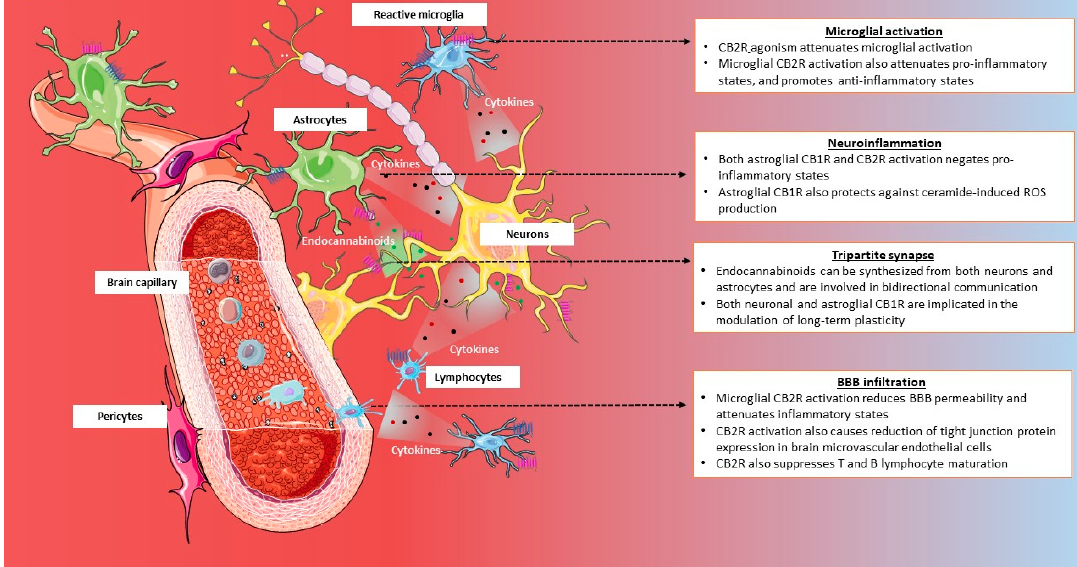
Figure 4. Regulation of synaptic activity and neuroinflammatory states by cannabinoid receptors. CB2R located on both microglial and astroglial cells are involved in the attenuation of inflammatory states. They do so by inhibition of microglial activation, reduced secretion of pro-inflammatory cytokines, and increased secretion of anti-inflammatory cytokines, and limiting the infiltration of peripheral immune cells. The CB2R is also expressed in the brain microvascular endothelial cells whereby they regulate expression of tight junctions, and further limit chemotaxis and transmigration of peripheral immune cells into the CNS. The CB2R also limits T- and B-cell proliferation and immunomodulation. Astroglial CB1R also promotes an anti-inflammatory state while simultaneously lowering levels of pro-inflammatory cytokines. Additionally, both neuronal and astroglial cells secrete endocannabinoids which are involved in modulation of synaptic strengthening by LTP and LTD. Additionally, astroglial CB1R activation has also been demonstrated to protect against excitotoxic neuronal damage and some forms of neurotoxic damage.